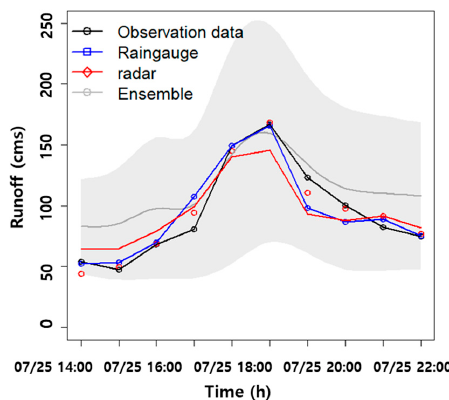
Figure 16. Optimum runoff hydrograph using the blending technique in the verification event.